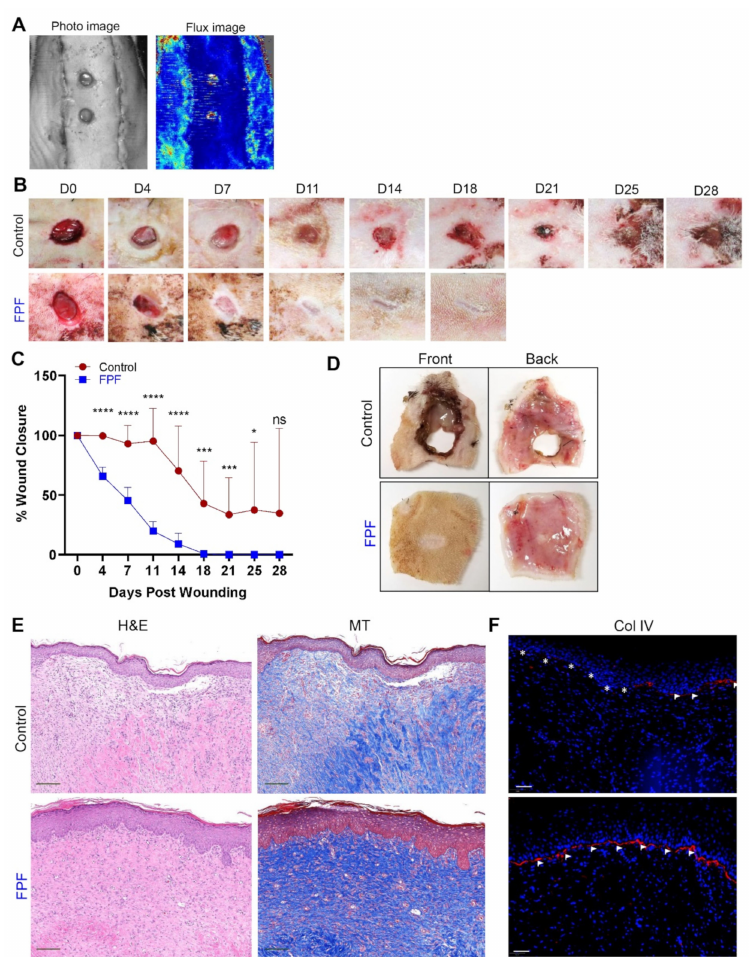
Figure 4. FPF accelerates wound closure in a rat ischemia wound model. ( A ) Representative photo image (left panel) and Doppler flux image (right panel), 10 min after completion of surgery, to confirm presence of ischemia in the bipedicle flap region. ( B ) Representative photographs of wounds taken over a 28-day period after wounding in control and FPF-treated groups. ( C ) Wound areas were measured and expressed as a percent of the wound area at day 0. Mean-SD for 5 rats per treatment group are shown for each time point on the graphs. N = 10, ns: not significant, * p < 0.05, *** p < 0.005, **** p < 0.001 FPF versus control. ( D ) Representative front and back photographs of necropsied tissue at day 28 after wounding for control and FPF-treated animals. ( E ) The structural integrity of healed tissue after wound closure in control and FPF-treated animals was assessed histologically by staining tissue sections with H&E (left panel) or MT (right panel). Scale bar = 5 × , 192 µ m ( F ) Basement membrane in the tissue samples collected after wound closure was visualized by collagen IV (Col IV) staining (red). Nuclei were counterstained with DAPI (blue). White asterisks highlight the absence of the basement membrane; white arrowheads highlight the basement membrane. Scale bar = 50 µ m. N =